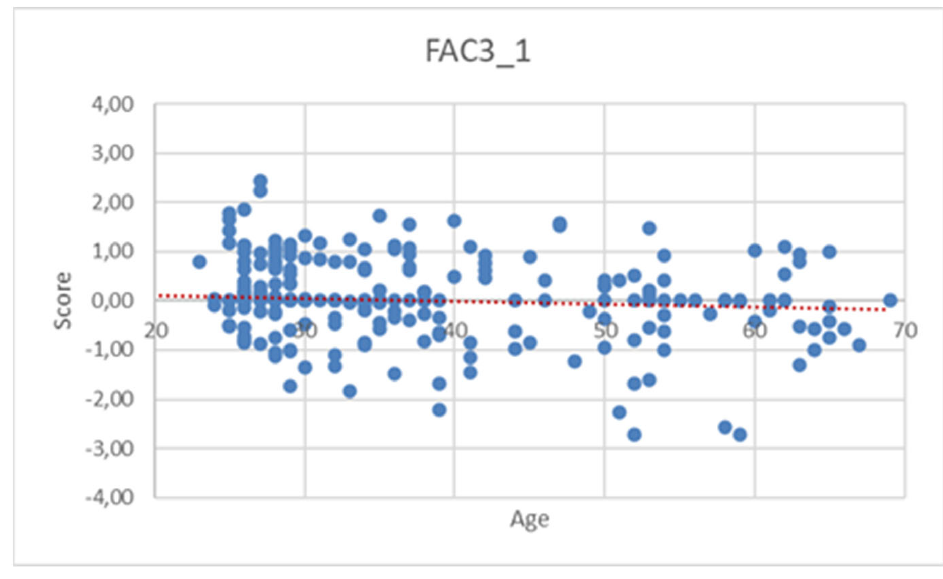
Figure A12. Scatterplot and trendline for PC S3.